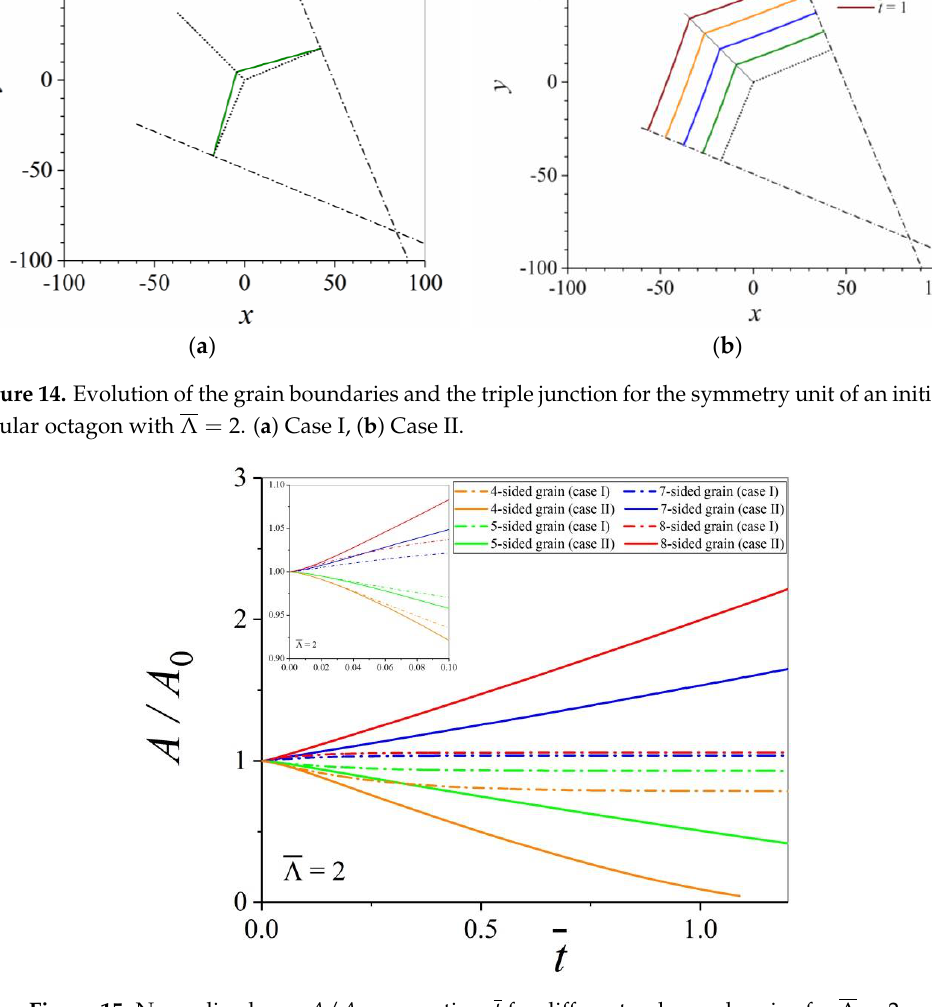
Figure 15. Normalized area A / A 0 versus time t for different polygonal grains for Λ = 2 .